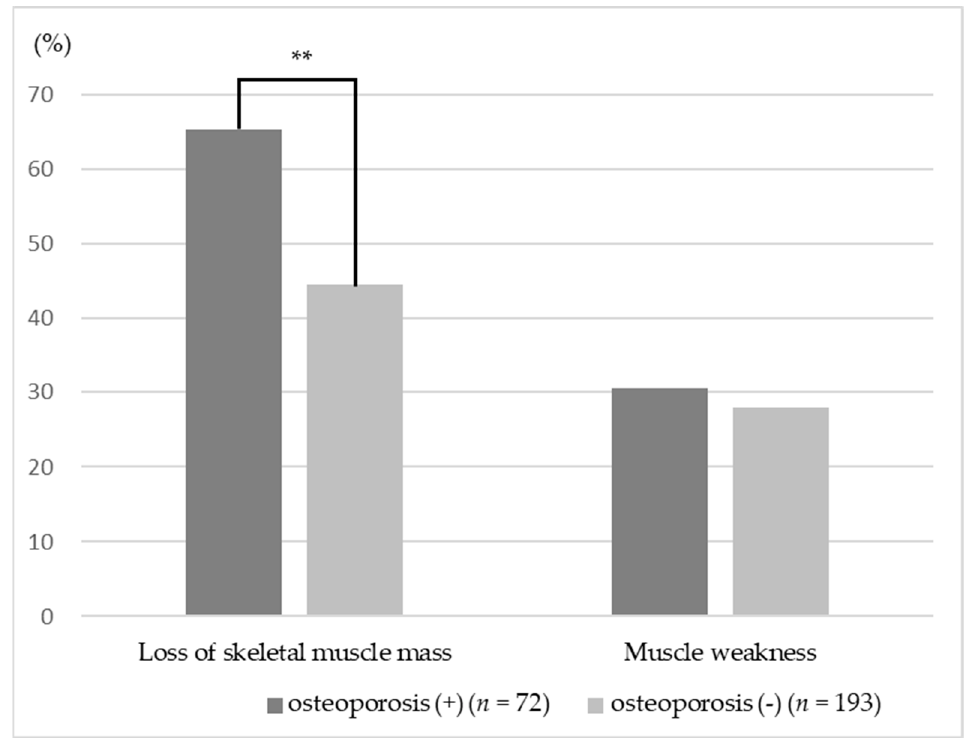
Figure 2. Ratio of loss of skeletal muscle mass and muscle weakness; ** p < 0.01.